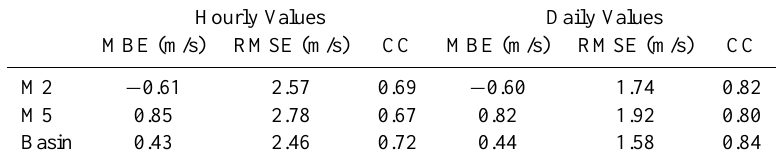
Table 7. Hourly and daily statistics for the wind speed in terms of mean bias error (MBE) and root mean square error (RMSE).